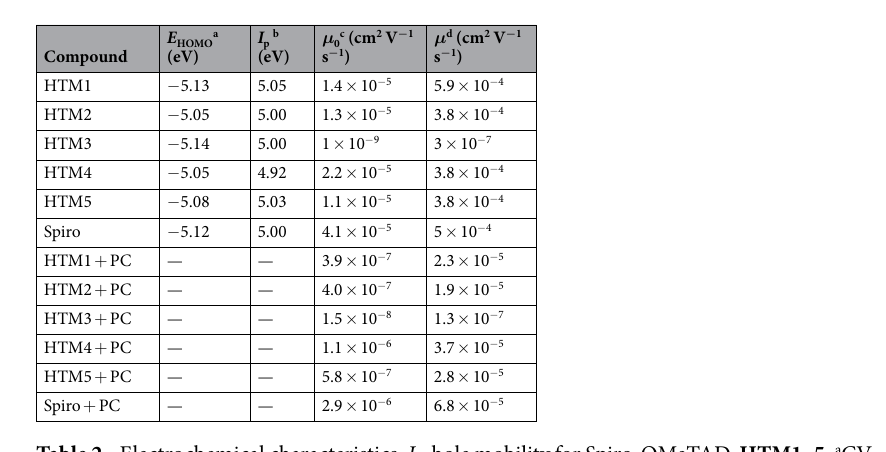
Table 2. Electrochemical characteristics, I p , hole mobility for Spiro-OMeTAD, HTM1–5 . a CV measurements were carried out at a glassy carbon electrode in dichloromethane solutions containing 0.1 M tetrabutylammonium hexafluorophosphate as electrolyte and Pt wire as the reference electrode. Each measurement was calibrated with ferrocene (Fc). Conversion factors: ferrocene in DCM vs SCE 0.46 34 , SCE vs SHE: 0.244 35 , SHE vs. vacuum: 4.43 36 . b Ionization potential was measured by the photoemission in air method from films. c Mobility value at zero field strength. d Mobility value at 6.4 × 10 5 V cm − 1 field